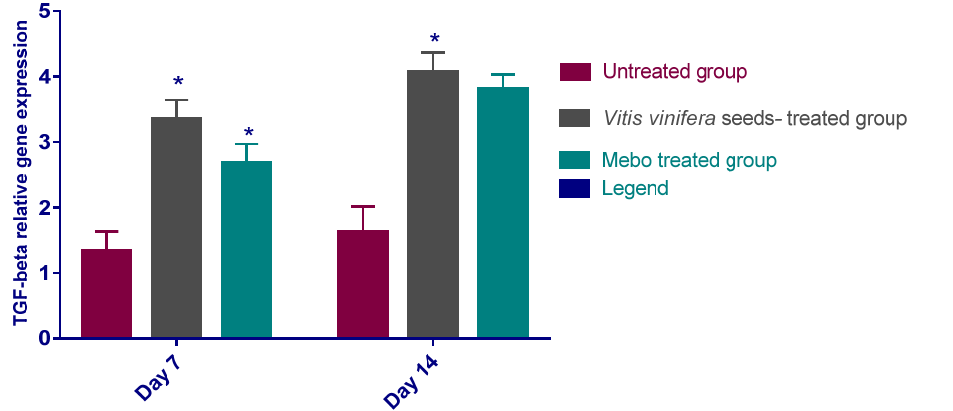
Figure 5. Relative gene expression of TGF- β in wound layers of various groups. After making normalization to glyceraldehyde 3-phosphate dehydrogenase (GAPDH), the data indicate a fold difference in expression relative to the normal control group. The bars reflect the mean ± SD and are based on the results of three independent investigations. A one-way ANOVA test is utilized to measure whether there is a significant variation between groups, where: * p < 0.001 when compared to the untreated group on a specified day, and p < 0.001 when compared to the Mebo ® group on the same day.